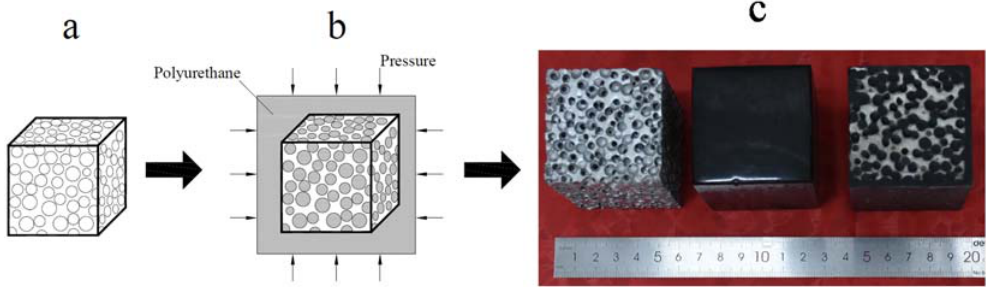
Figure 1. Fabrication procedure of the spherical cell porous aluminum ‐ polyurethane composites (SCPA-PU composites): ( a ) The specimen of the spherical cell porous aluminum (SCPA); ( b ) fabrication method of the SCPA-PU composites; and ( c ) image of specimens from left to right: SCPA, polyurethane (PU), and SCPA-PU composites.